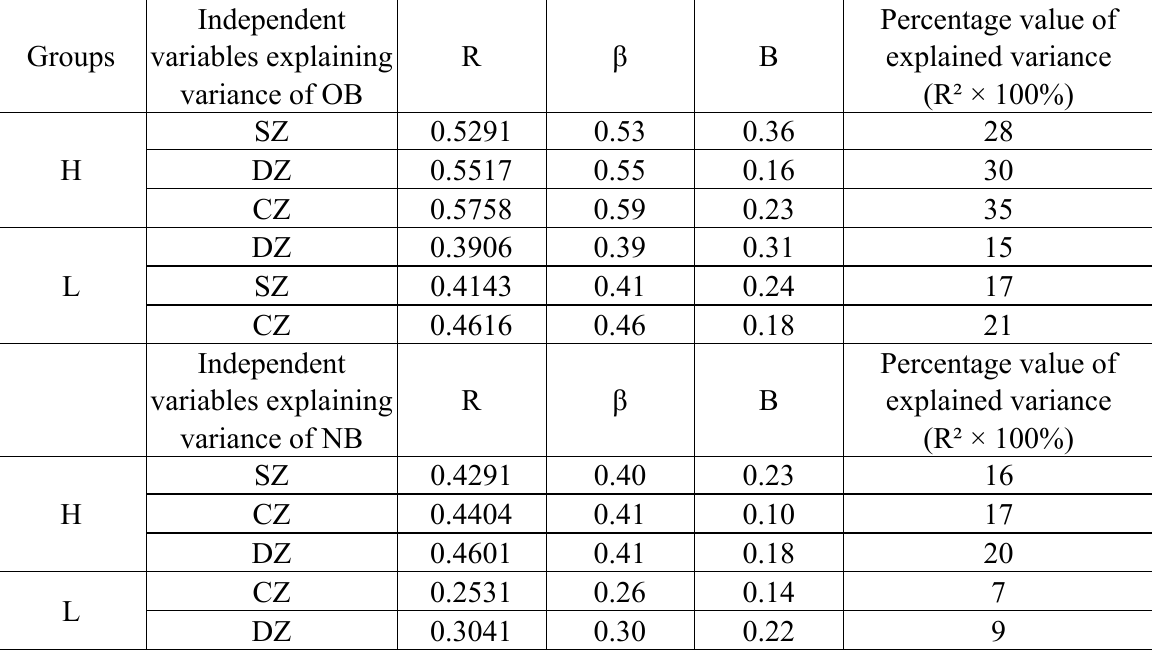
Table 1. Independent variables relating to meaning of life: a sense of meaning in life (SZ)—as a state of meaning in life, attainment of goals (CZ) and affirmation of life (DZ)— as a sign of accomplishment of the need of meaning in life accounting for the variance of religious experience: God's presence (OB) and God's absence (NB) in groups of students with a high (H) and low (L) level of conscience sensitivity to oneself and moral